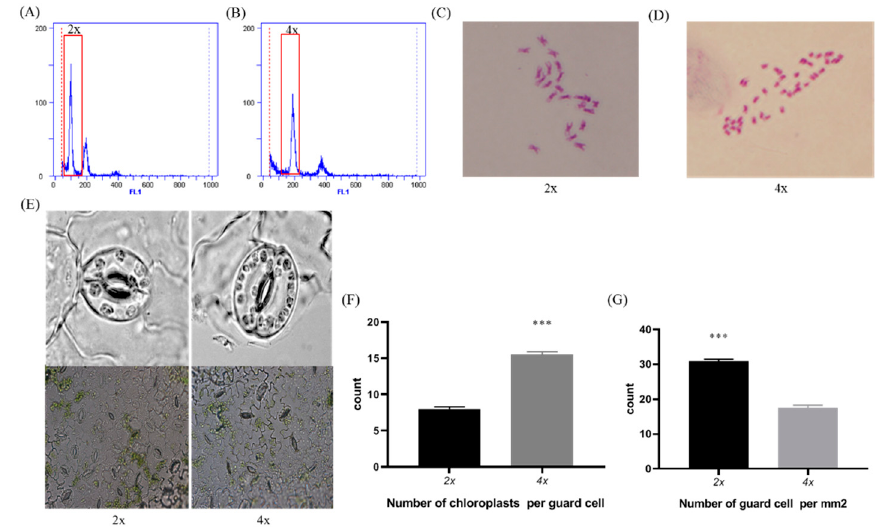
Figure 1. Flow cytometry analysis and chromosome counting of diploid and tetraploid watermelon. Relative nucleic DNA content of ( A ) diploid watermelon and ( B ) tetraploid watermelon; chromosome number of ( C ) diploid watermelon and ( D ) tetraploid watermelon; ( E ) stomata and chloroplast of guard cells in diploid and tetraploid plants; ( F ) number of chloroplasts per guard cell; ( G ) number of guard cells per mm 2 . Values are means ± SD (n = 3). Asterisks indicate statistically significant differences compared with diploid watermelon by Student’s t -test (*** p < 0.001).